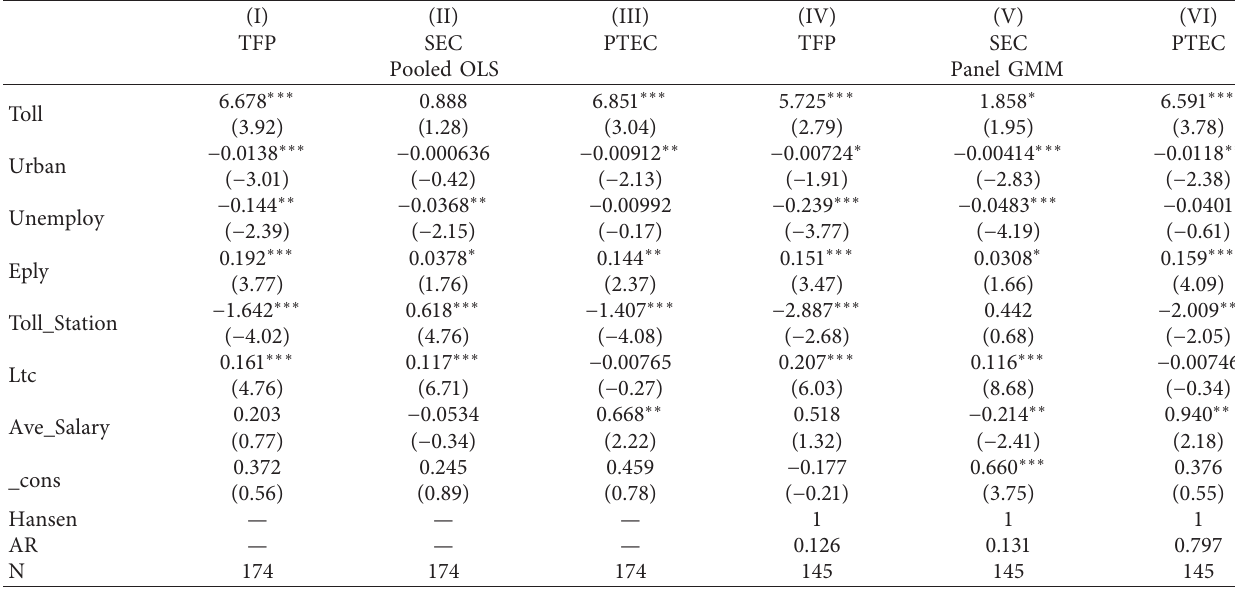
Table 4: Parameter estimation